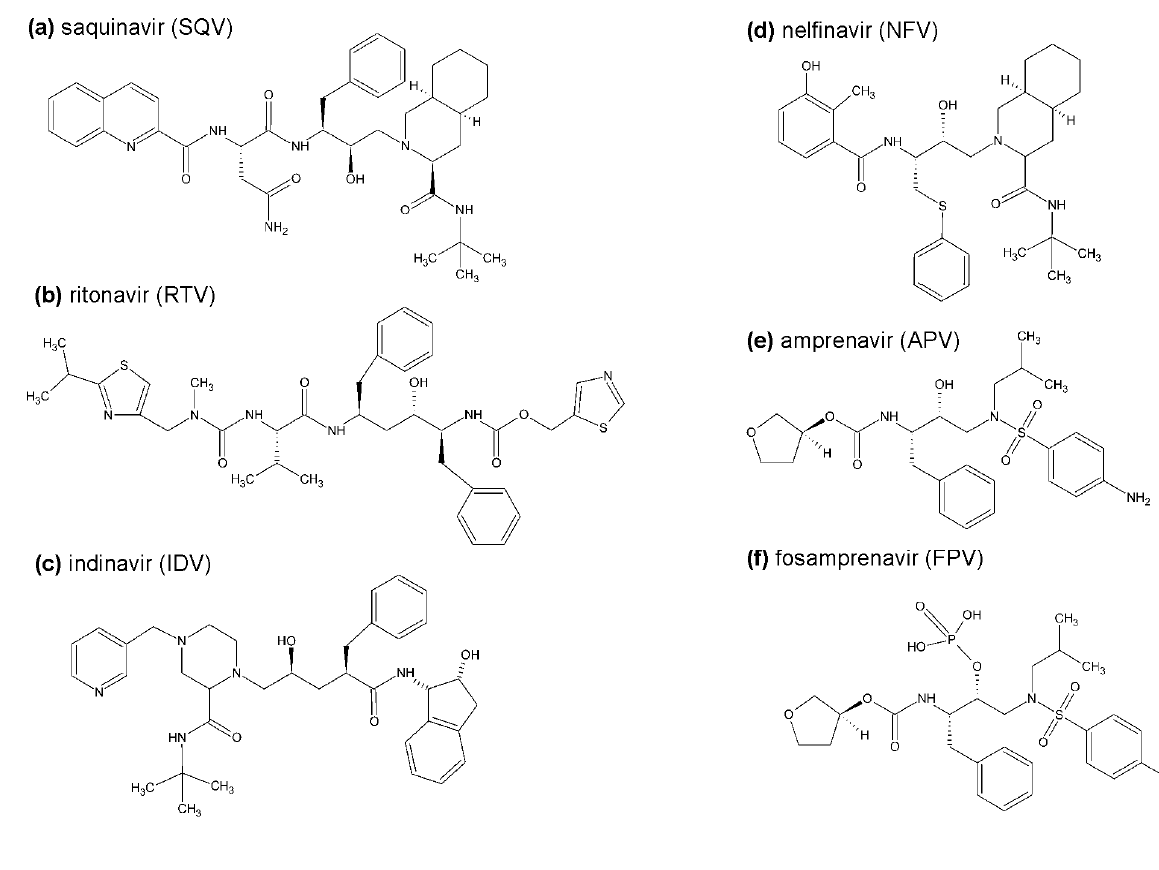
Figure 3. Chemical structures of the first generation HIV protease